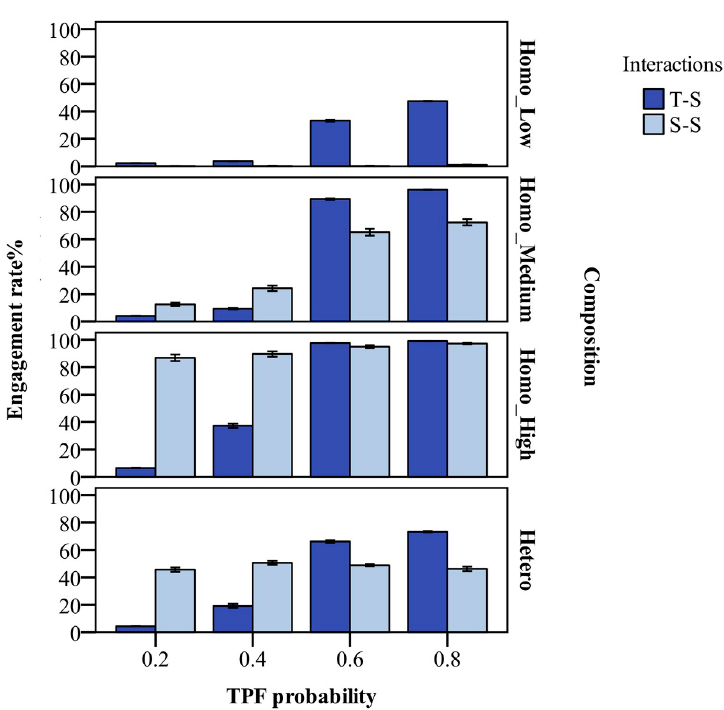
Fig 5. Simulated classroom engagement in interactions with the teacher and peers under teacher feedback effects and near-seated peer group influence. The meanings of TPF, Composition, Homo_Low, Homo_Medium, Homo_High and Hetero are the same to those in Fig 3. T-S and S-S refer to teacher-student and student-student interactions respectively. The effects of teacher’s positive feedback probability and class engagement composition on classroom engagement rates are asymmetrical and